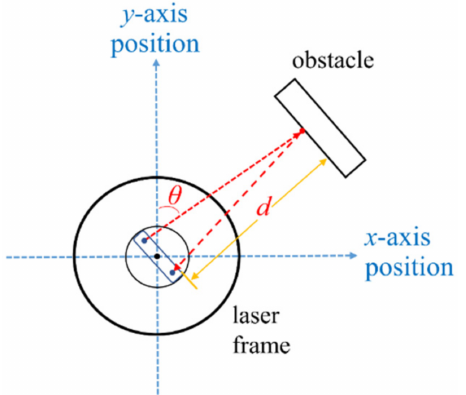
Figure 8. Triangulation measurement system of